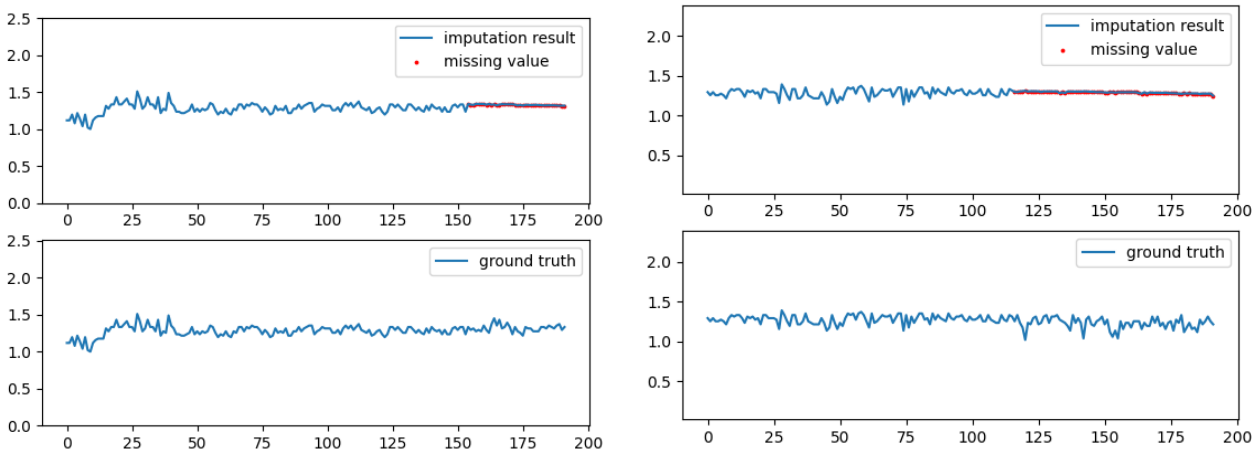
Figure 4. Imputation results of informer-WGAN method on electricity dataset at missing rates of 20% and 50%.